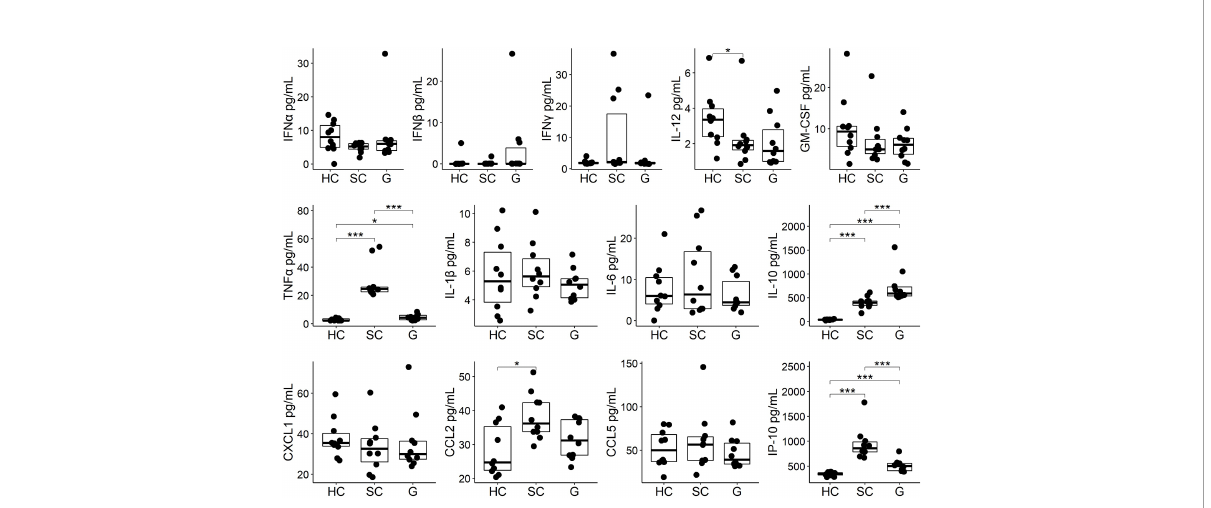
FIGURE 3 GABA treatment modulates circulating cytokines and chemokines in SARS-CoV-2-infected K18-hAC2 mice. Three days post-infection sera from individual SARS-CoV-2 infected control (SC) mice that were untreated, or were GABA treated (G), were collected and frozen at -80°C until analysis by a multiplex assay as described in Methods. In addition, sera from age-matched healthy control (HC) B6 mice were studied. The non- normally distributed data are shown in boxplots with the borders of the box indicating 1st and 3rd quartile of each group (n=10), the bolded line indicating the median. The data were analyzed by Wilcoxon rank-sum tests. *p<0.05,